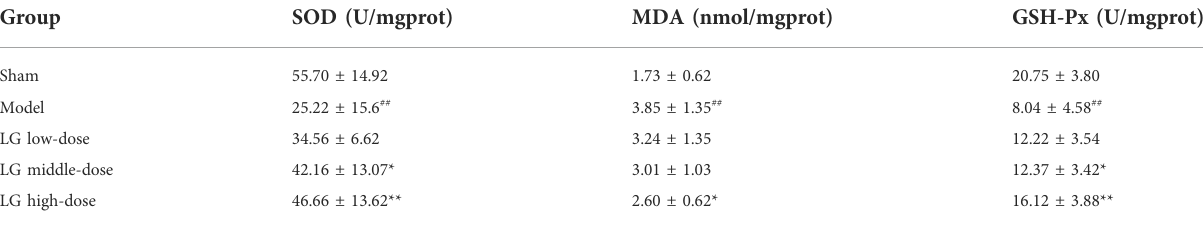
TABLE 2 Acitivities of SOD and GSH-Px and level of MDA in lung tissue homogenates after LG treatment. Group